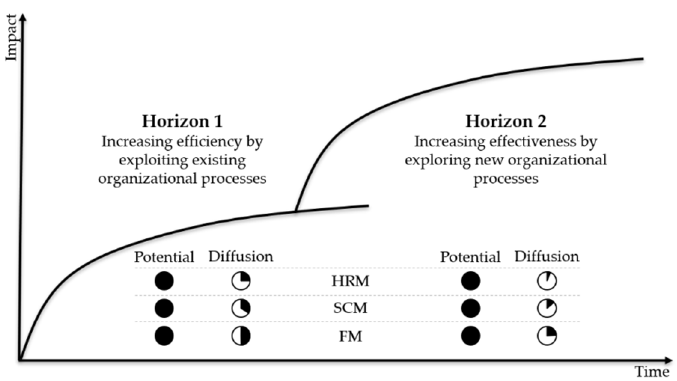
Figure 2. Potential and diffusion of AI ‐ based applications in business support functions.